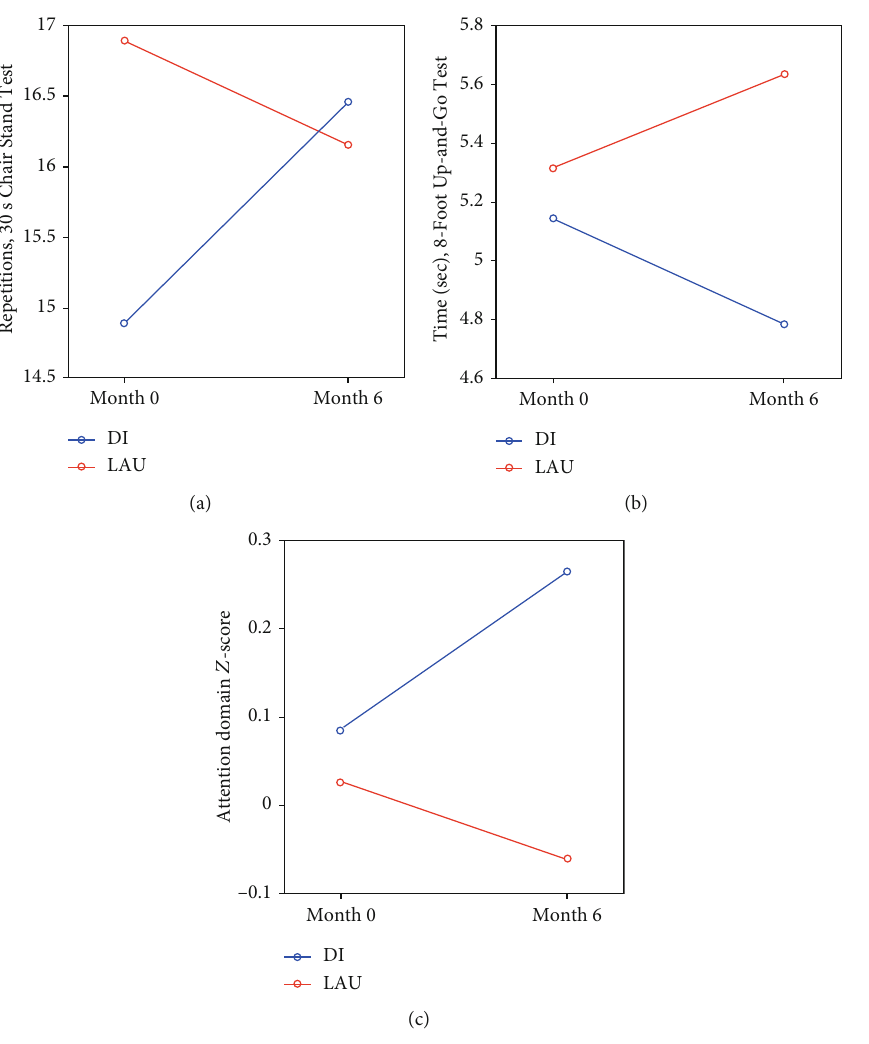
Figure 2: Mixed ANOVA results: signi fi cant time ∗ group changes. DI: dance intervention; LAU: life as usual. (a) Number of repetitions, 30-Second Chair Stand Test (increase means improvement); (b) time, 8-Foot Up-and-Go Test (decrease means improvement); and (c) attention domain Z